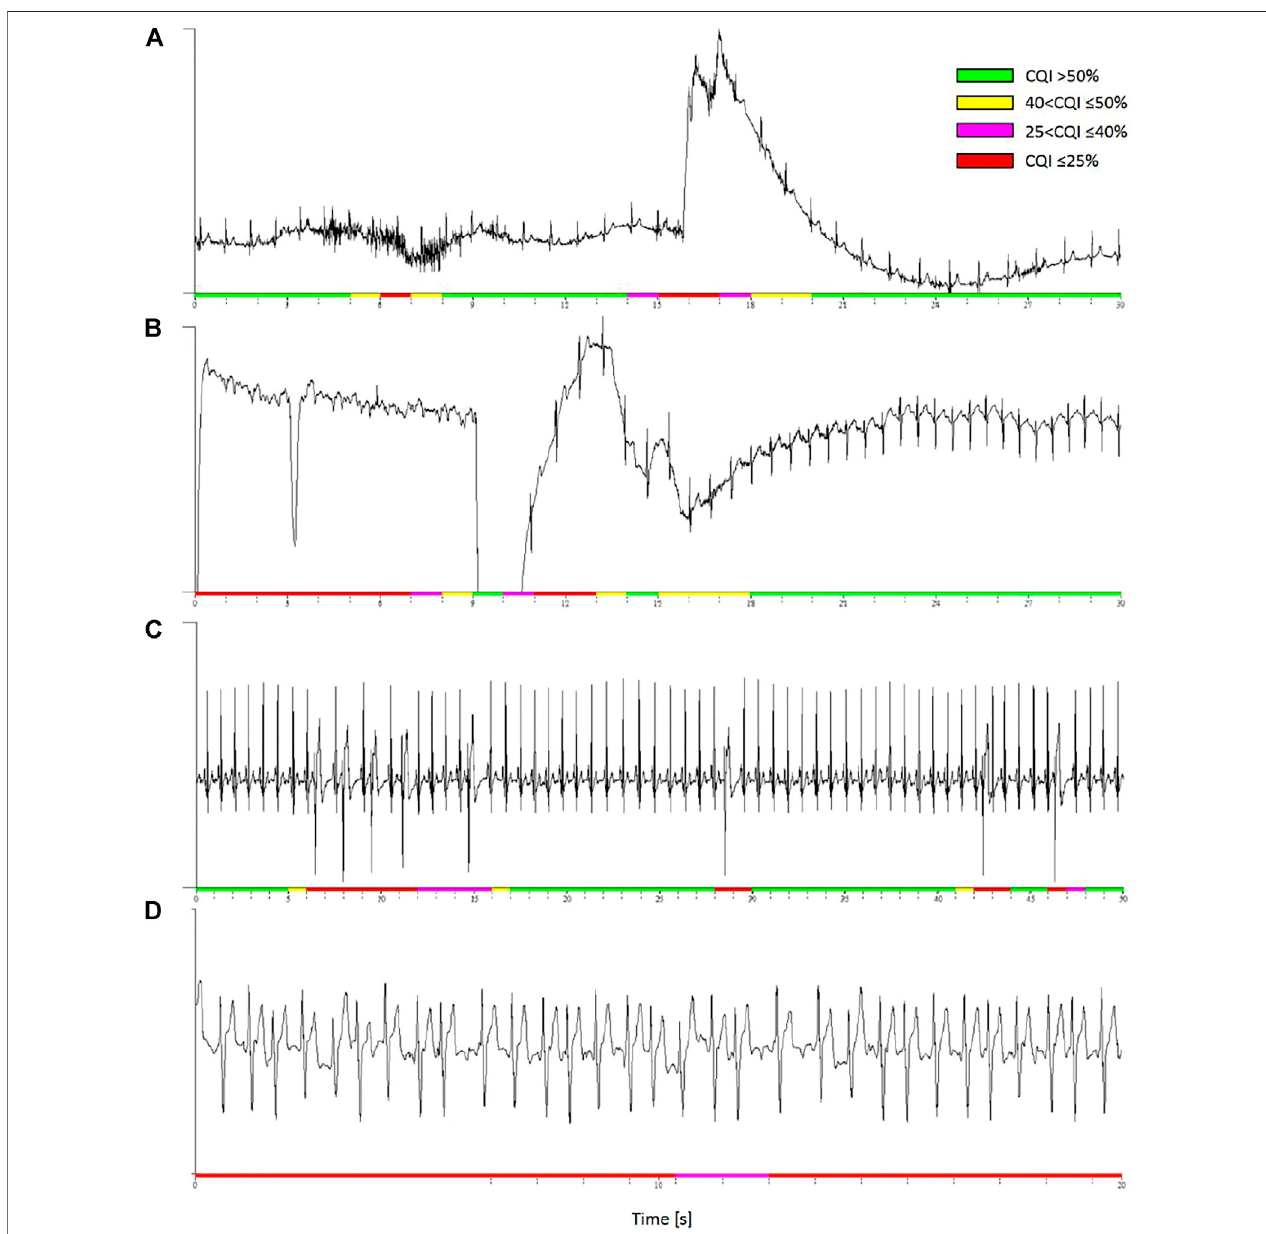
FIGURE 8 | Examples of discarded ECG segments by running cepstral analysis. Colors represent four CQI levels. (A) : low CQI values identify a short burst of muscle noise and a following movement artefact. (B) : low CQI values detect signal loss likely due to a poor contact between textile electrodes and skin. (C) : premature beats in a high quality recording are locally associated to low CQI values. (D) : atrial fi brillation is associated to persistently low CQI even in high quality ECG recording.